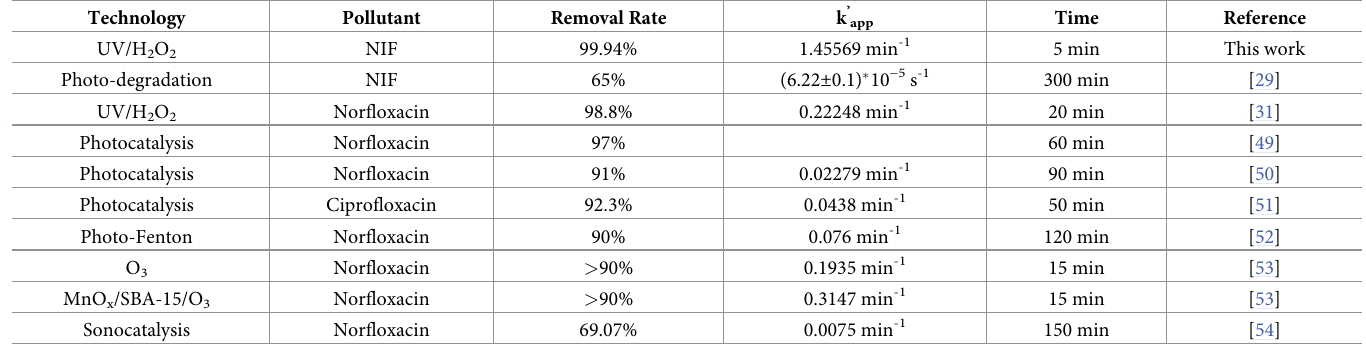
Table 1. Summary of removal performance of antibiotics via